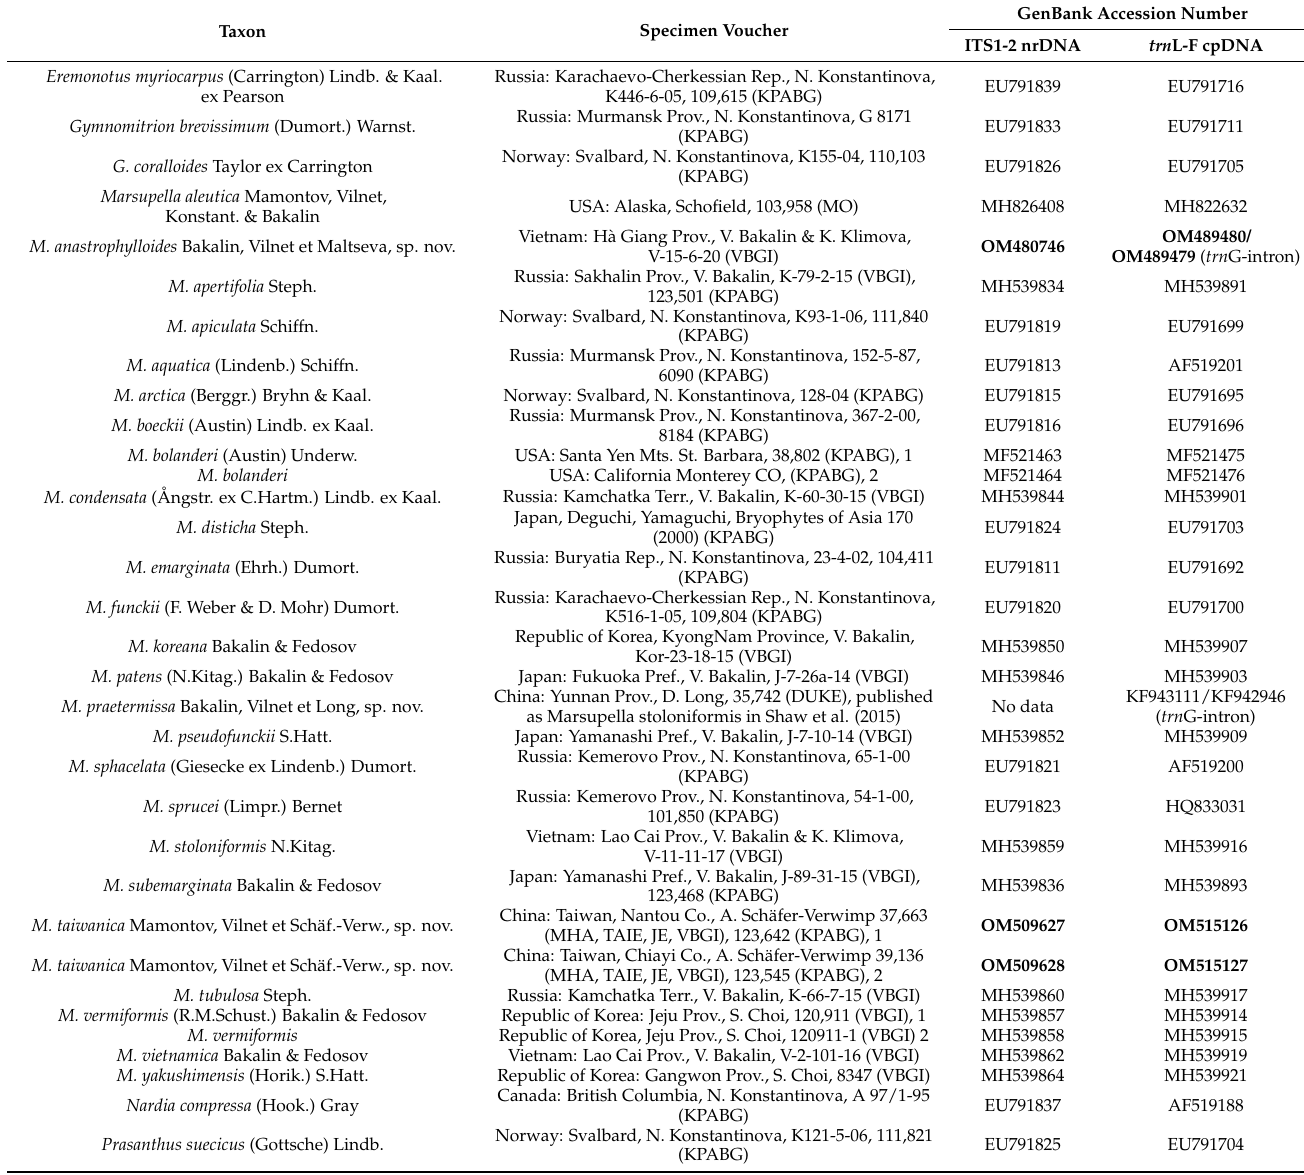
Table 2. The list of tested specimens with voucher details and GenBank accession numbers. Newly generated accessions are marked in